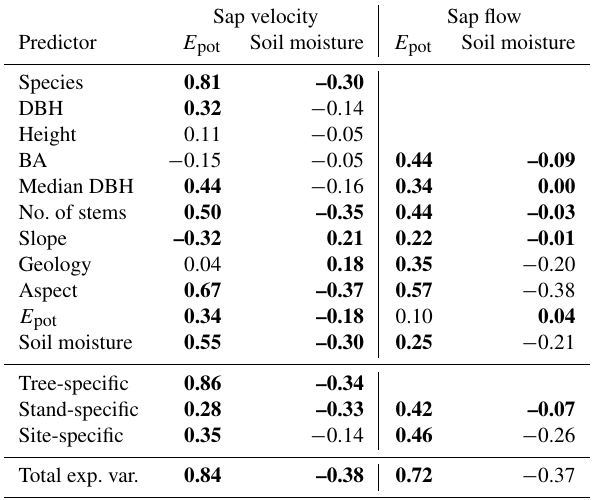
Table 2. Spearman rank correlation between the time series of the different predictors’ explained variance and the time series of po- tential evaporation ( E pot ) and soil moisture. Values in bold are sig- nificant correlations (at α =